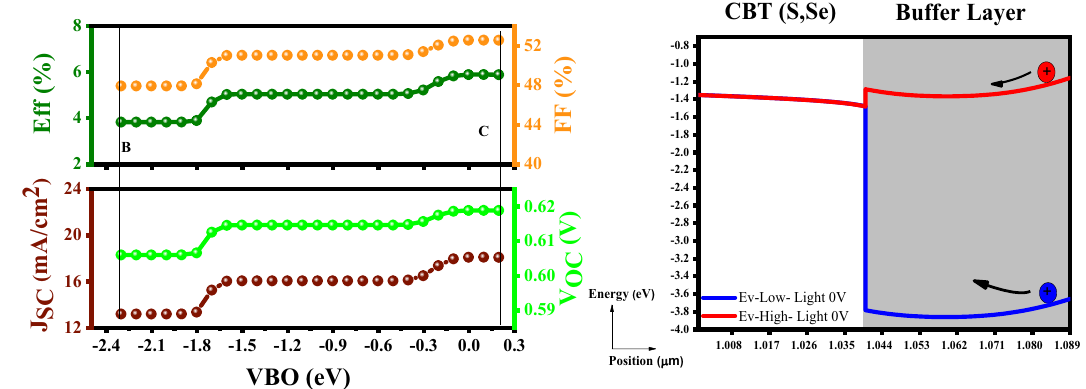
Figure 6. Variation of the solar cell parameters of the CBT (S, Se) solar cells with different VBO of the In 2 S 3 layer.